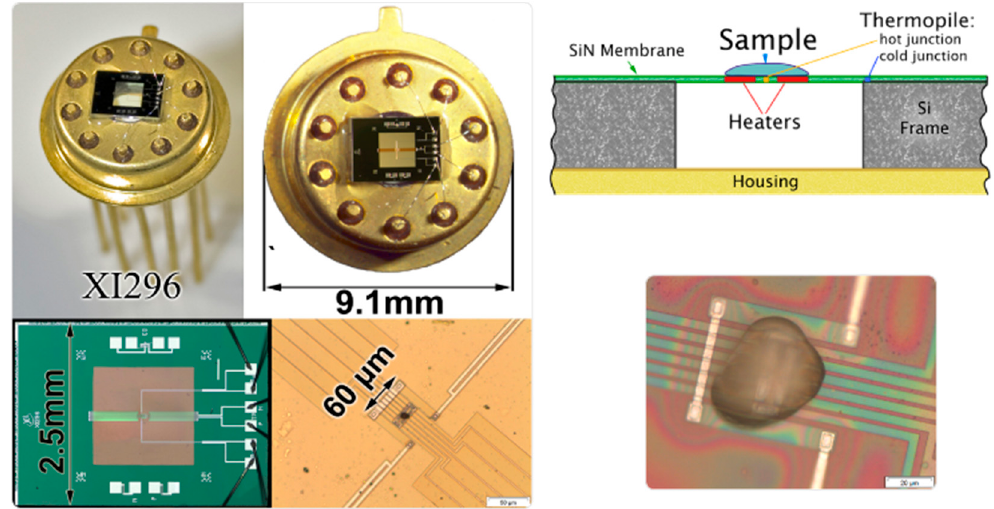
Figure 1. Schematic cross-section and zoomed-in view of the calorimeter chip XEN 39395 (XI296), Xensor Integration, Netherlands [45] . Reproduced with permission of [46] .